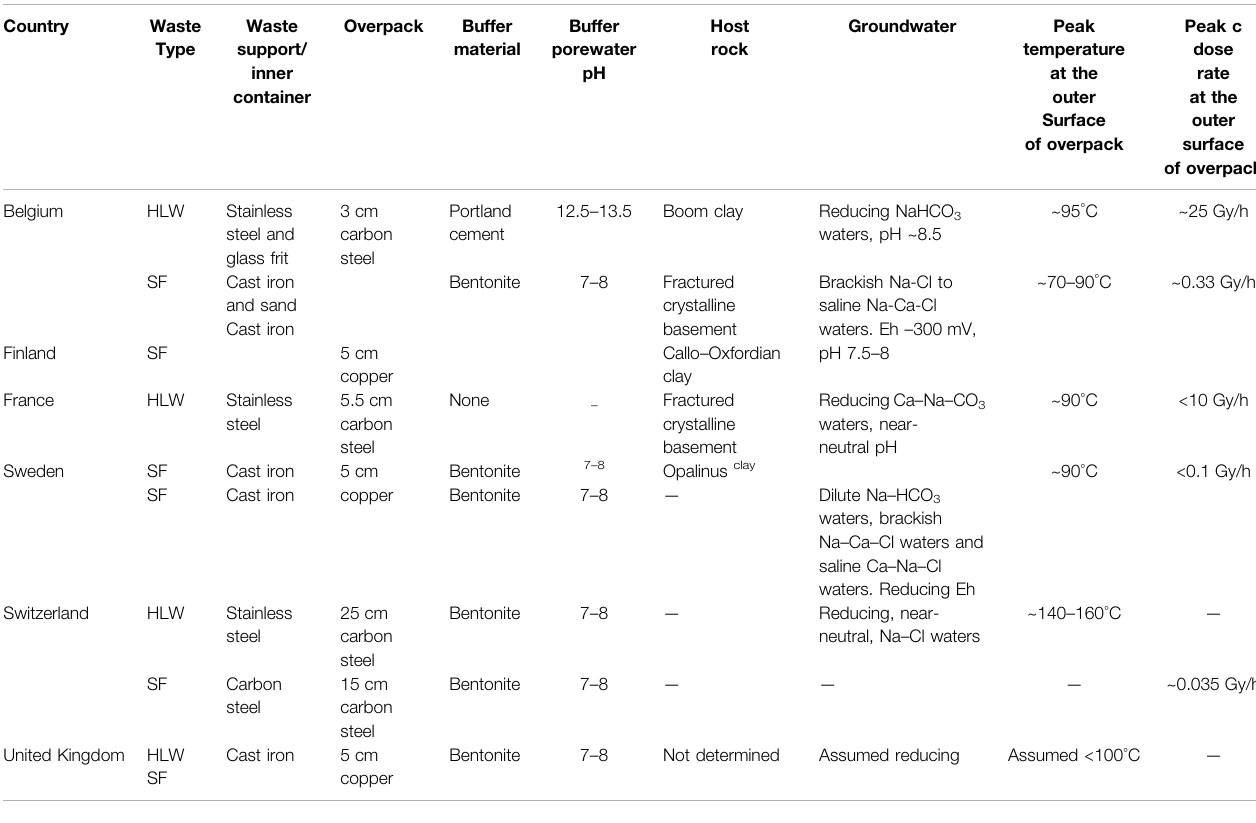
TABLE 1 | Characteristics of the selected disposal systems (Bennett and Gens, 2008).